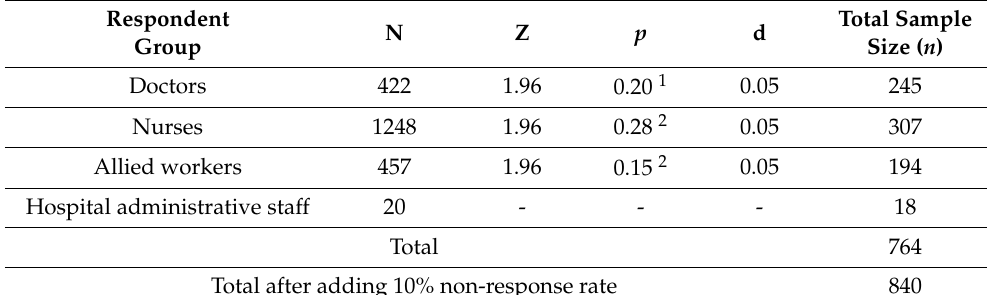
Table A1. Sample size estimation for all target population